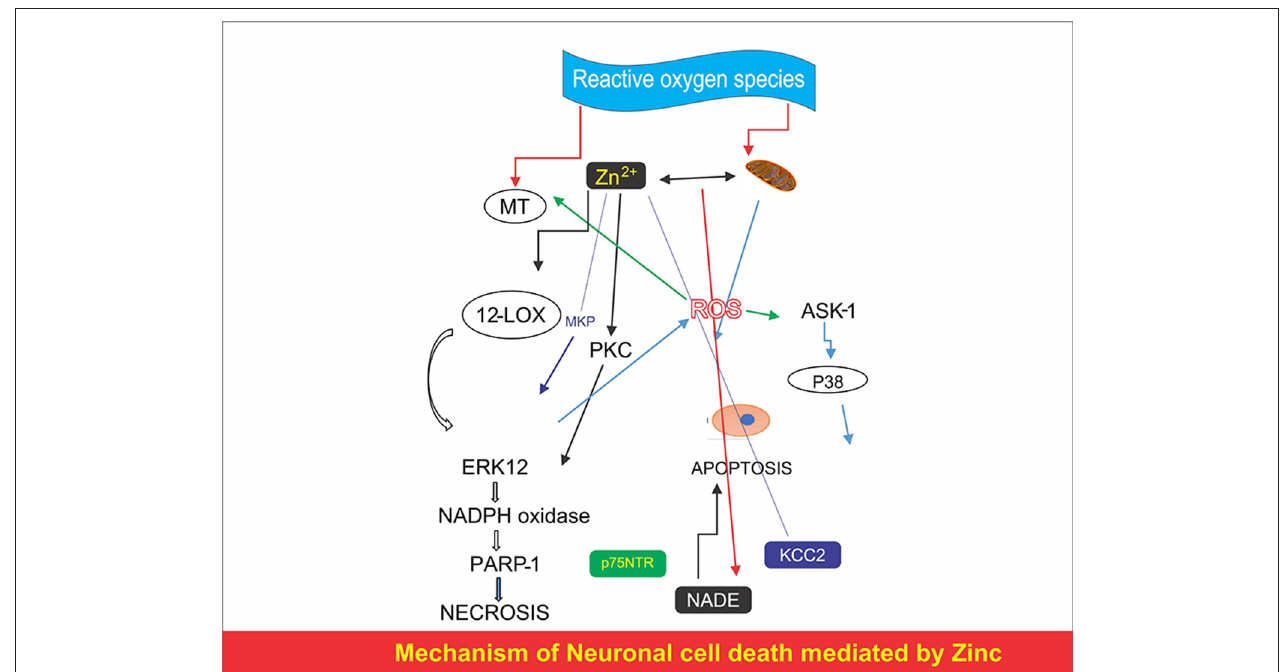
FIGURE 1 | Mechanism of neuronal cell death mediated by zinc.